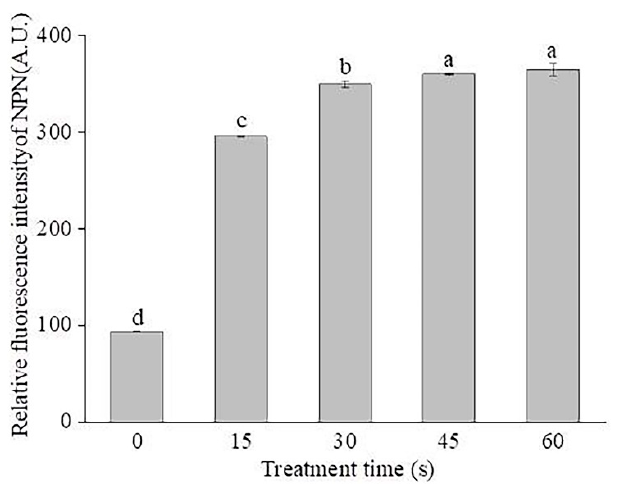
Figure 6. Changes in the outer membrane permeability of P. deceptionensis CM2 cells as determined by the n-phenyl-1-napthylamine (NPN) assay. Means with the different letters are significantly different from each other ( p < 0.05).